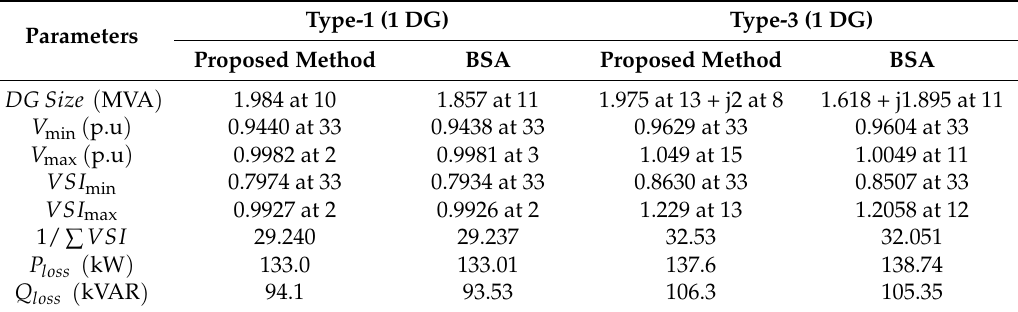
Table 5. Comparison of the proposed method with other algorithms for Type-1 (1 DG) and Type-3 (1 DG) for 2nd objective function.